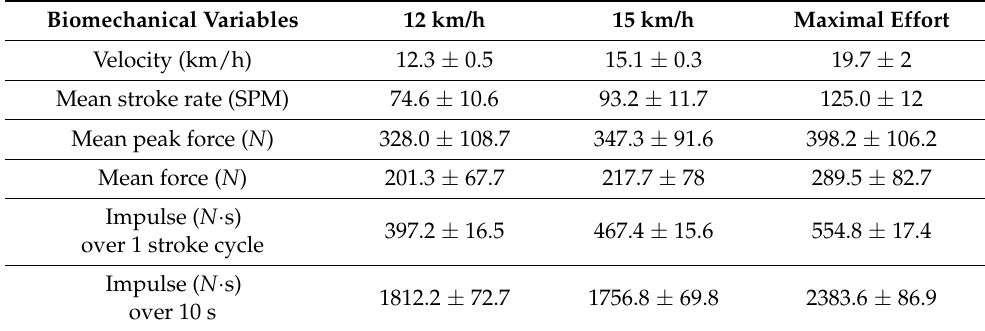
Table 2. The variables averaged for 25 participants.